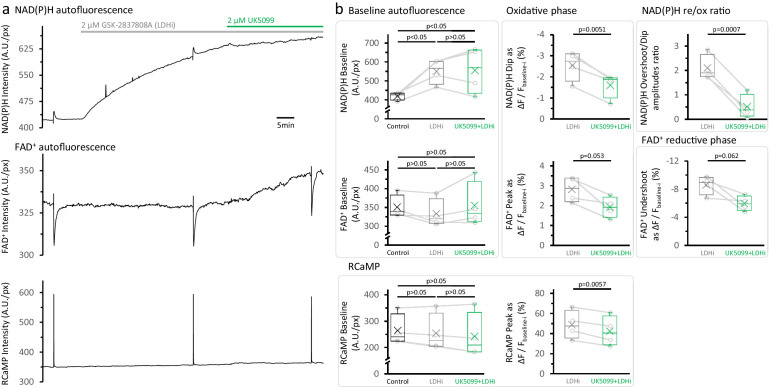
LDH inhibition elevates the NAD(P)H autofluorescence at baseline but does not restore the NAD(P)H overshoot after the treatment with UK5099.(a) Representative traces of simultaneously recorded NAD(P)H and FAD+ autofluorescence signals, and RCaMP fluorescence, in a population of DGCs in an acute brain slice. (b) Effects of the sequential application of 2 µM GSK-2837808A and 2 µM UK5099 on the parameters derived from the NAD(P)H and RCaMP transients. The treatment with GSK-2837808A alone significantly elevated the baseline of the NAD(P)H autofluorescence by 31 ± 12%, likely because of the combination of two factors: an increased pyruvate availability and a higher NADH transfer from the cytosol to the mitochondria via the MAS. Since the responses to stimulation seems to occur independently from the changes in the NAD(P)H baseline. The FAD+ signal at baseline was unaltered by LDH inhibition and showed the expected trends after MPC inhibition with UK5099. Baselines were compared using a repeated measures ANOVA, with a Student-Newman-Keuls post-test (Nslices = 4 and Nmice = 3). Comparisons for other parameters were restricted to before and after the application of UK5099, in the continuous presence of an LDH inhibitor. These comparisons were performed using a paired t-test.